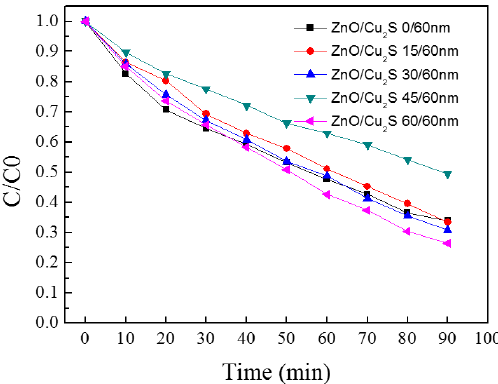
Figure 18. The photocatalytic activity of ZnO/Cu 2 S/glass complex films for different thickness.